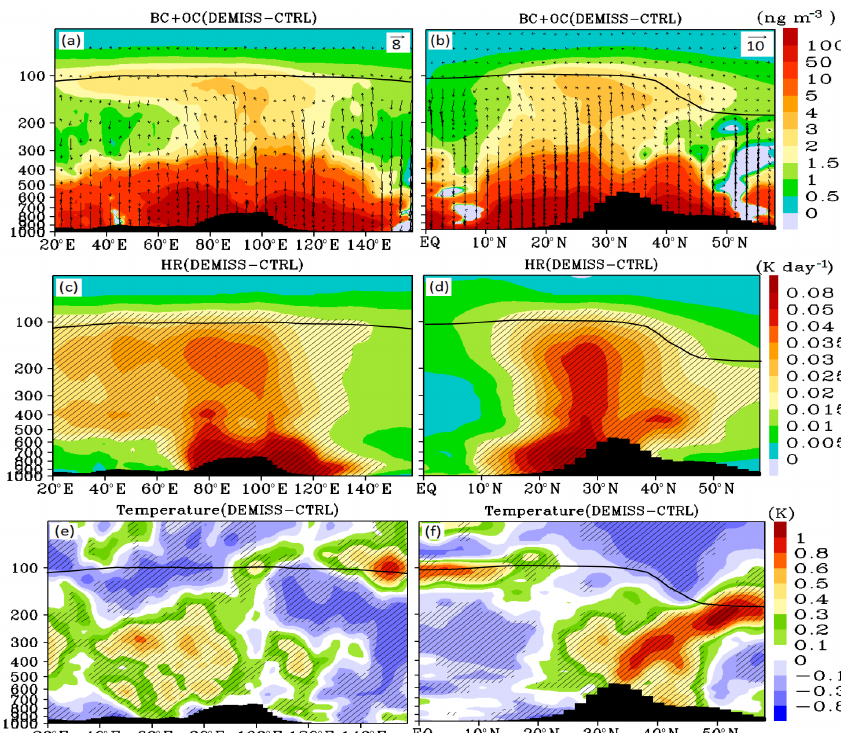
Figure 4. Distribution of seasonal mean (June–September) anomalies (Demiss-CRTL), of BC and OC aerosols (ngm − 3 ) together averaged for (a) 15–35 ◦ N and (b) 80–110 ◦ E. Black arrows indicate wind vectors (the vertical velocity field has been scaled by 1000). (c, d) Same as (a, b) but for heating rate anomalies (Kday − 1 ). Distribution of anomalies in temperature (K) averaged for (e) 15–35 ◦ N and (f) 80–110 ◦ E. A black line represents the tropopause. The tropopause is averaged over 15–35 ◦ N for panels (a, c, e) and over 80–110 ◦ E for panels (b, d, f) . Black hatched lines in panels (c, d, e, f) indicate the 99% confidence